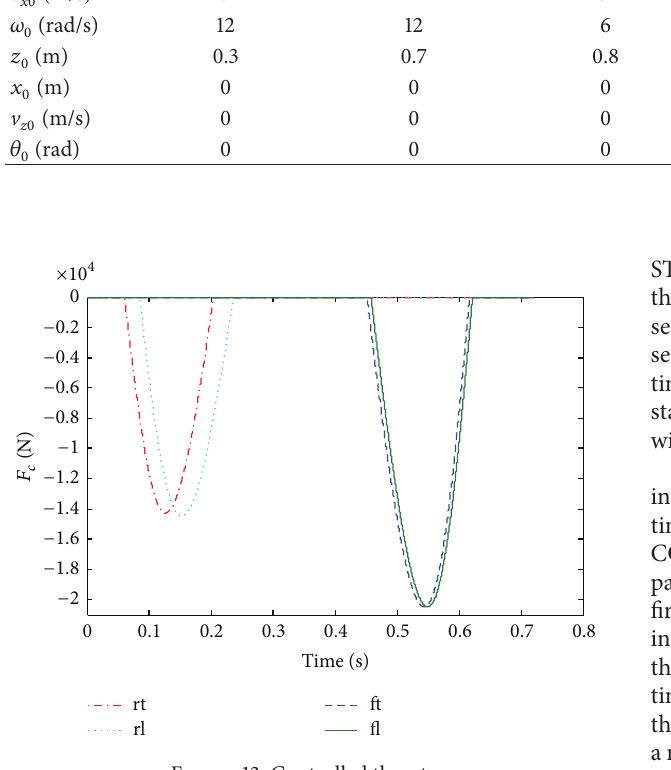
Figure 13: Controlled